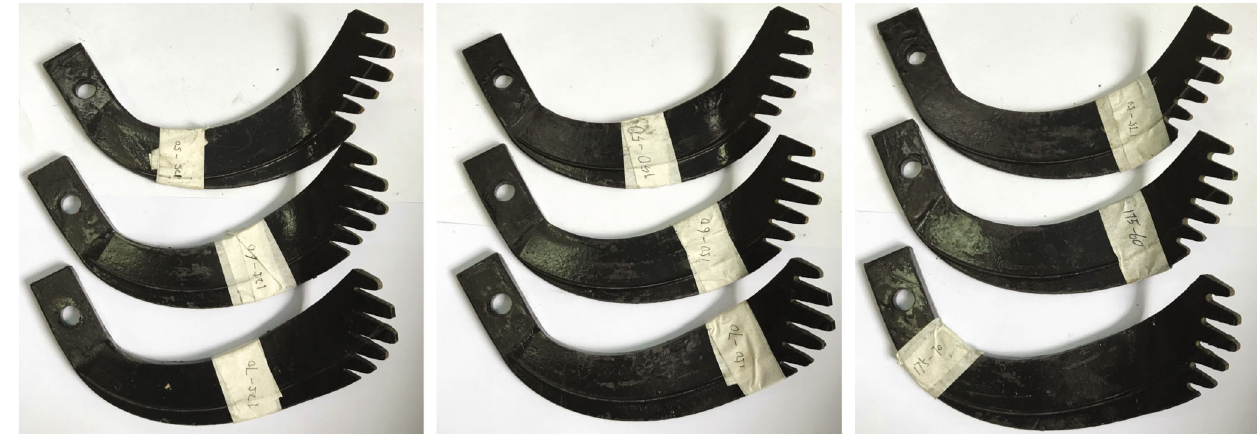
Figure 8: Nine biomimetic rotary tillage blades designed for the soil bin